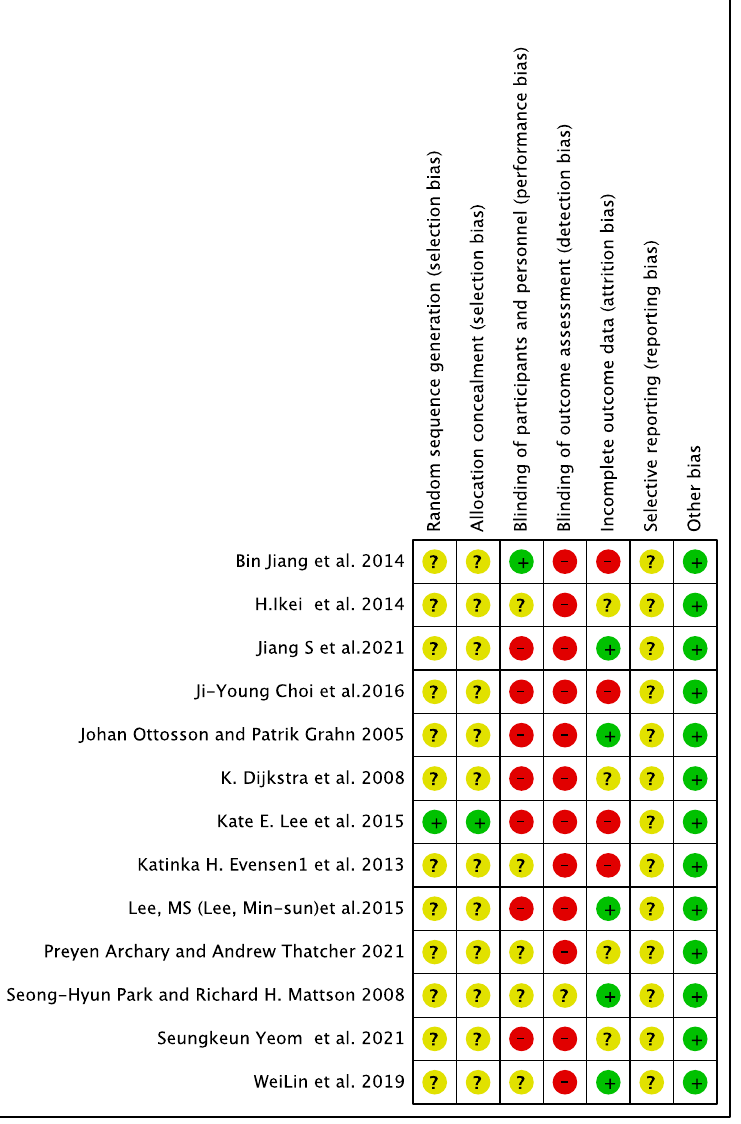
Figure A1. Risk of Bias table for included RCT studies. Bin Jiang et al., (2014) [5], H. Ikei et al., (2014) [40], Jiang S. et al., (2021) [45], Ji-Young Choi et al., (2016) [50], Johan Ottosson and Patrik Grahn (2005) [38], K. Dijkstra et al., (2008) [36], Kate E. Lee et al., (2015) [35], Katinka H. Evensen1 et al., (2013) [42], Lee, MS (Lee, Min-sun) et al., (2015) [46], Preyen Archary and Andrew Thatcher (2021) [41], Seong-Hyun Park and Richard H. Mattson (2008) [48], Seungkeun Yeom et al., (2021) [16], WeiLin et al., (2019) [12].